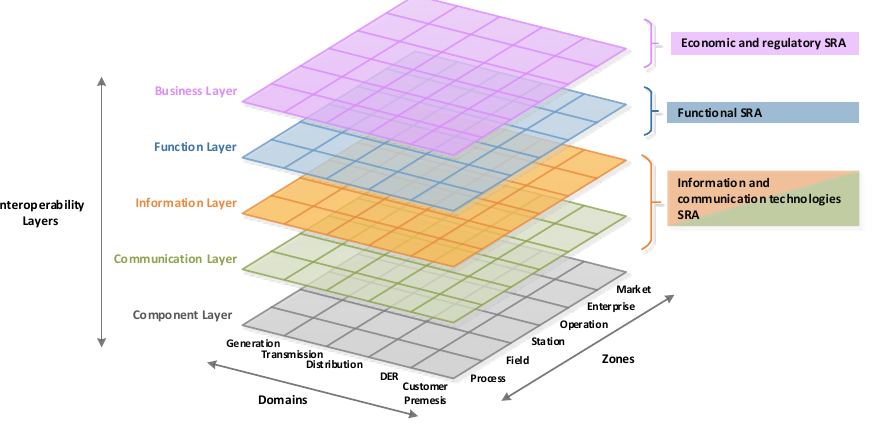
Figure 1. Mapping of focus areas to the